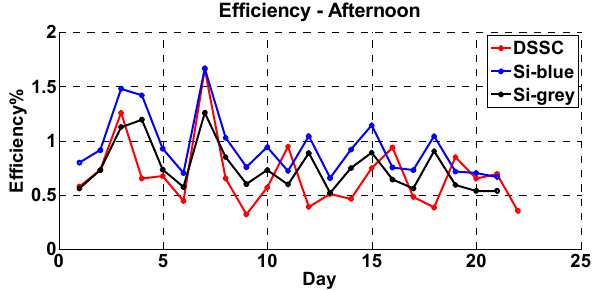
Figure 26. E ffi ciency profiles in the afternoon of the three generation